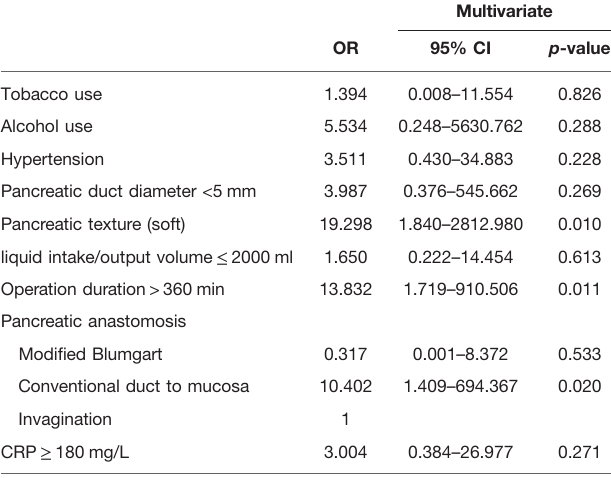
TABLE 6 | Multivariate analysis of grade C PPAP.